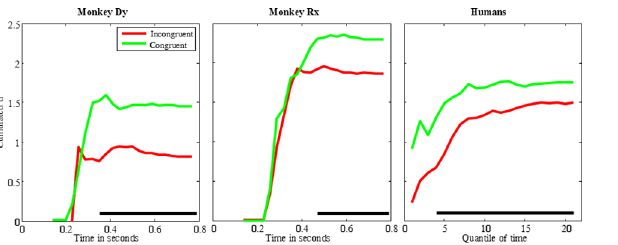
Fig 3. Cumulated D ’ as a function of time in the “ Real scene ” condition (bins of 30ms in monkeys, quantiles of relative time in humans: mean quantile duration = 20ms SEM +/0.6ms, first quantile starts at 370ms SEM +/- 11ms). The horizontal black line indicates the significance of the difference between congruent and incongruent trials (permutation test, 1000 permutations, α < 0.01)